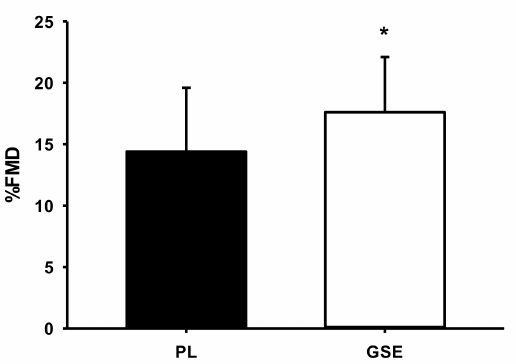
Figure 2. Flow-mediated dilatation after PL and GSE supplementation. FMD: flow-mediated dilation. Values are expressed as means ± SE. * p < 0.05. vs. PL